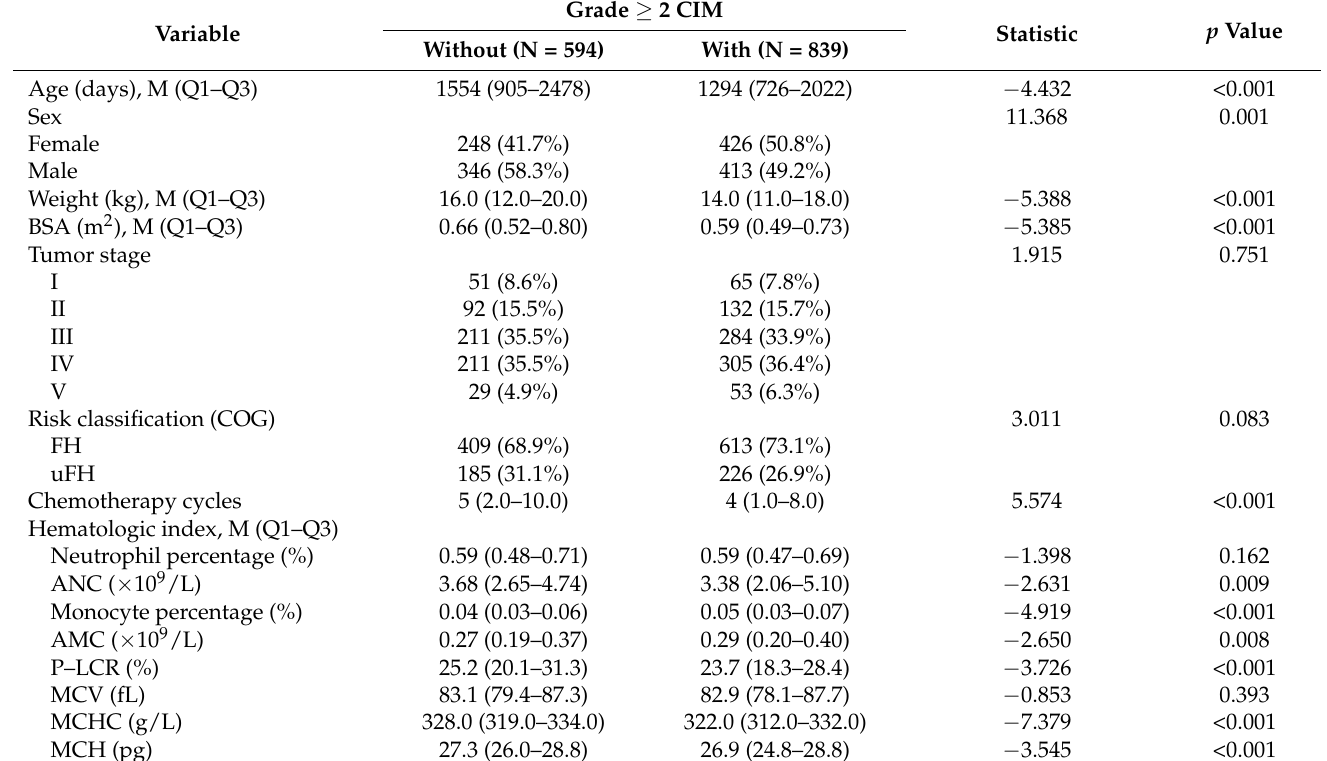
Table 2. Comparison of baseline characteristics of patients with and without